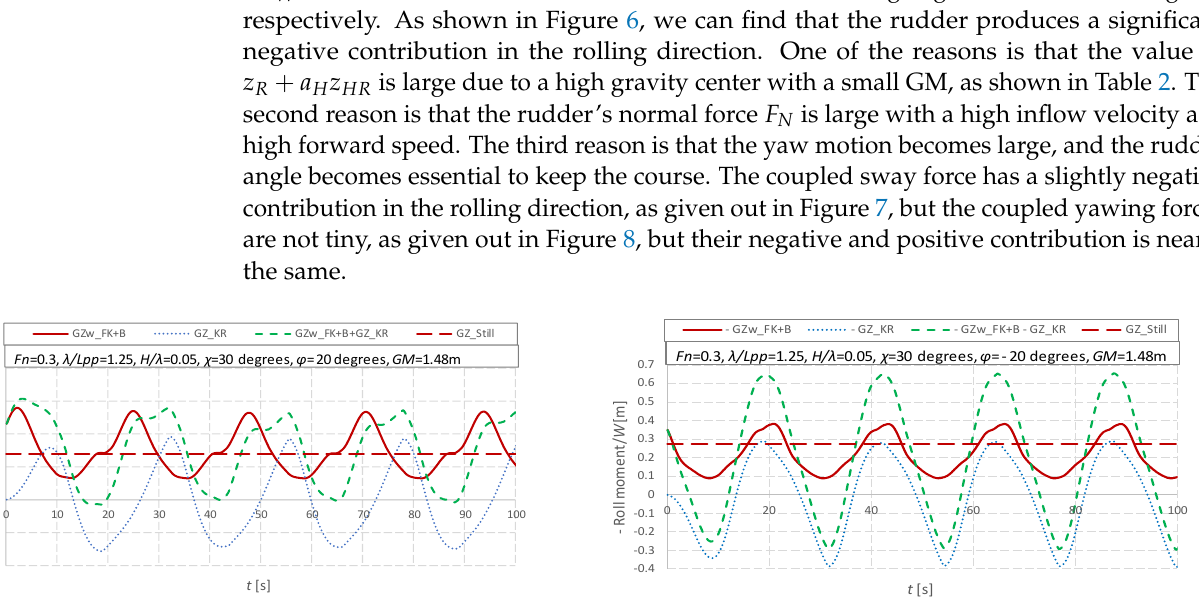
with φ = 20, −2 0 degrees, ( a ) starboard; ( b ) port. with ϕ = 20, − 20 degrees, ( a ) starboard; ( b ) port.